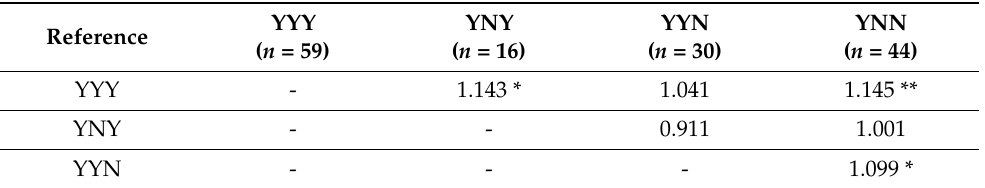
Table 3. Ratio of lung function (ppFEV1) for each pairwise comparison between four different conditions of A. fumigatus . YYY YNY Reference ( n = 59) YNY - - 0.911 1.001 - -